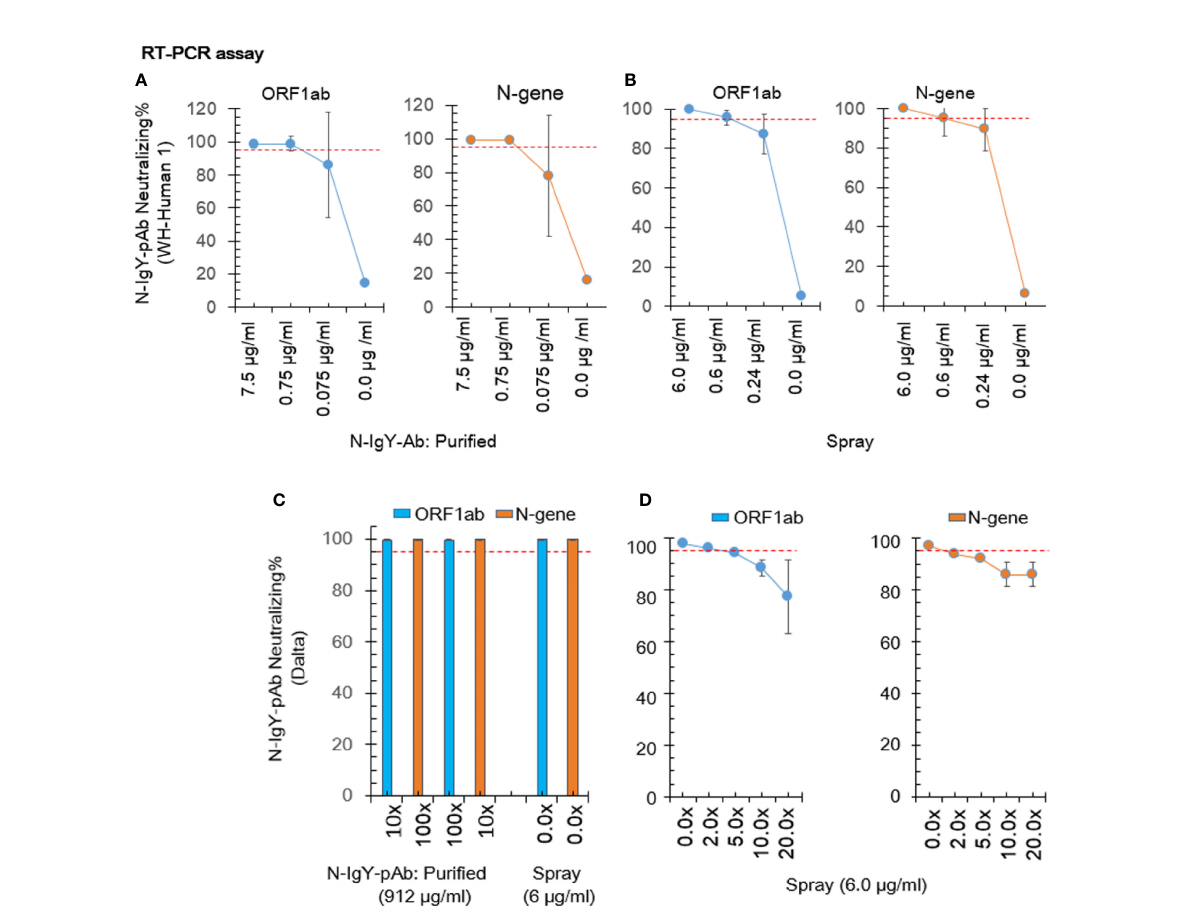
FIGURE 3 Neutralization test by RT-PCR. The nucleic acid concentration in the virus sample was calculated based on a formula including the Ct value (number of PCR cycles giving detectable values) of the open reading frame 1ab (ORF1ab) and the nucleocapsid protein (N-gene). The puri fi ed N-IgYpAb (A) or novel “ spray ” (B) against WH-Human 1 was carried out in the Center of Disease Control, Shenzhen, China. The “ spray ” against SARS-CoV-2 variants B.1.617.2 (Delta) and B.1.1.529 (Omicron) were carried out in the Key Laboratory of Virology, Wuhan University China (C) and the Wuhan Institute of Biological Products Co. LTD, China (D) , respectively. The mean ± SD was from each sample in replicate three times. The neutralization potential has to be achieved ≥ 95% (red dotted